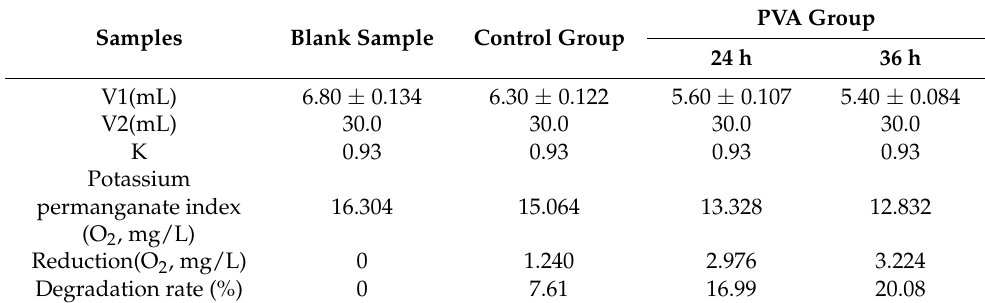
Table 2. The degradation of microspheres-immobilized Bacillus velezensis strain treating 50% concen- tration slaughter wastewater.